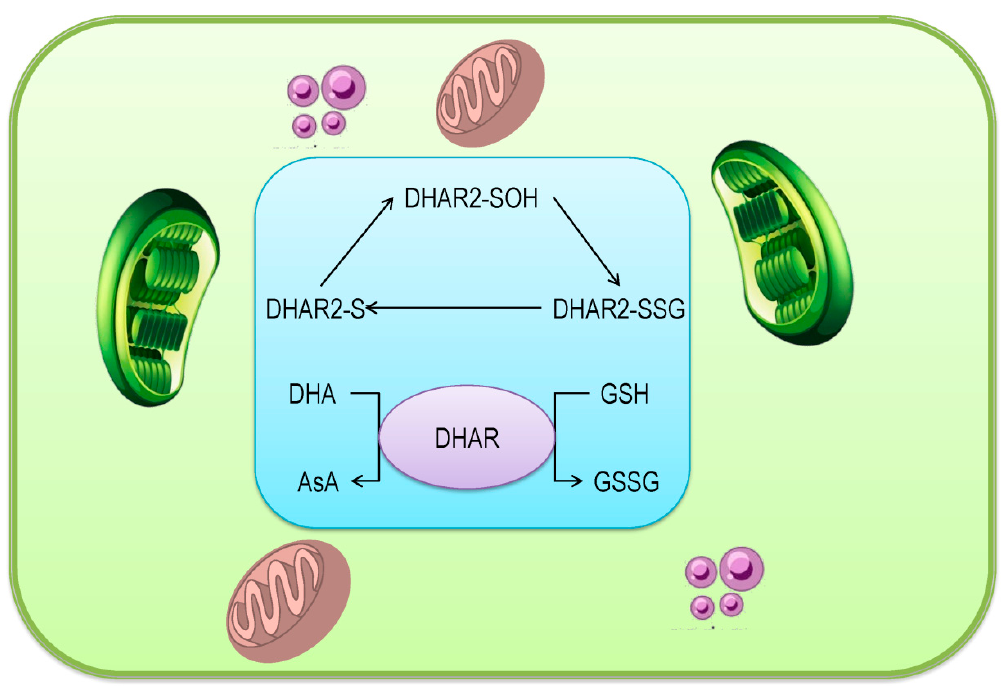
Figure 6. The mechanistic scheme, the ping-pong mechanism for the enzymatic reduction of dehydroascorbate (DHA).